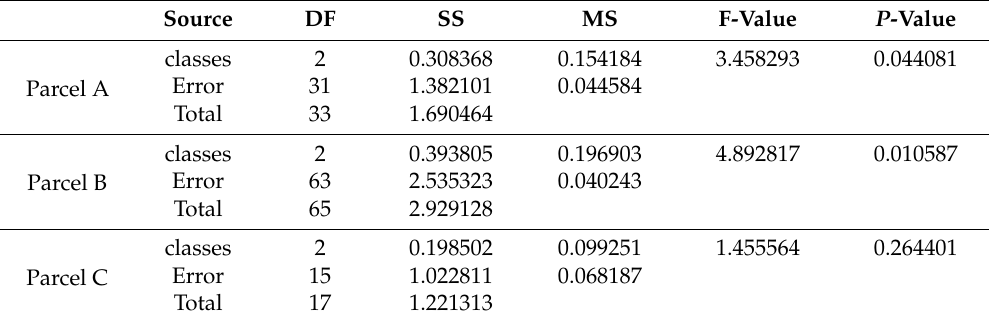
Table 5. Results of the ANOVA of satellite based NDVI sat map in relation to three vigour classes from in-field